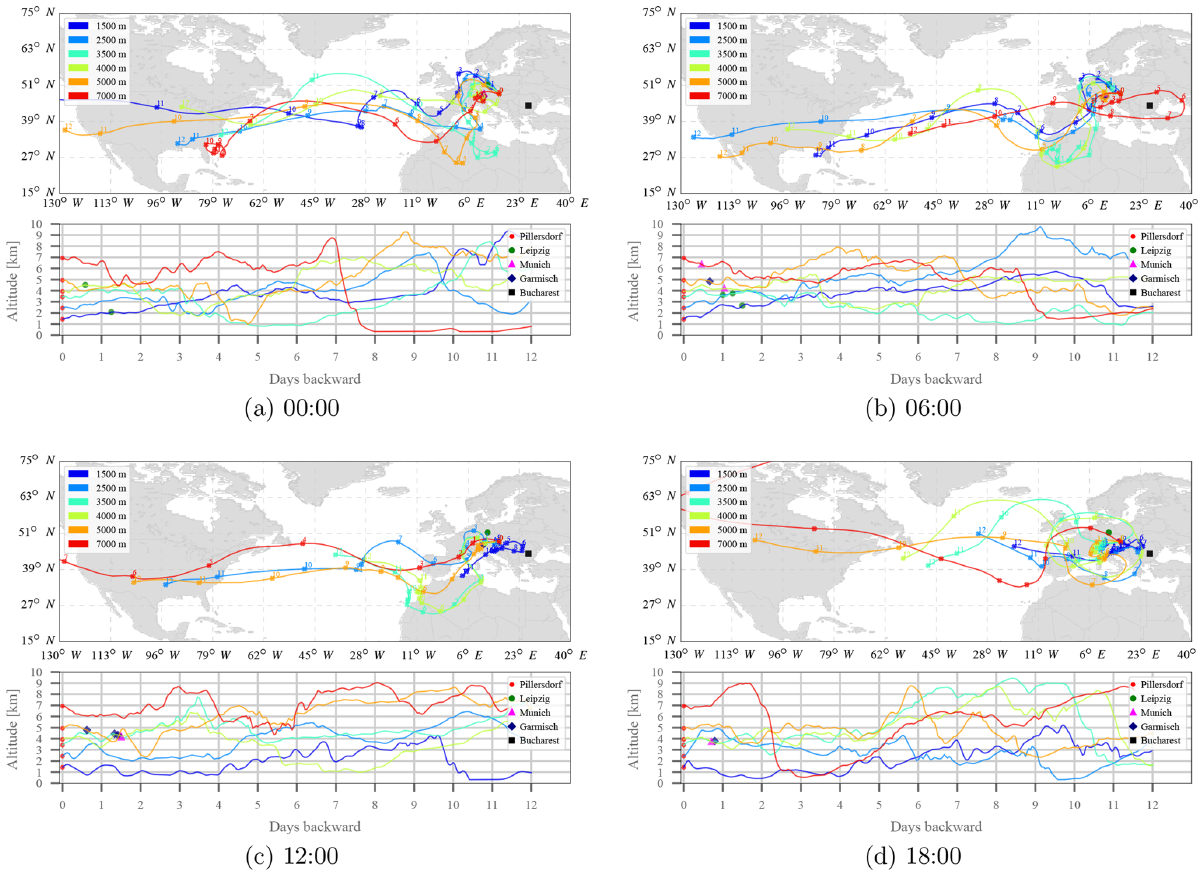
Figure 5. Pattern of back trajectories (upper plot of each panel) and their altitude profile, including overpassed lidar stations (lower plot of each panel) for Pillersdorf, 2 April 2014 at 00:00 (a) , 06:00 (b) , 12:00 (c) , and 18:00 (d) .